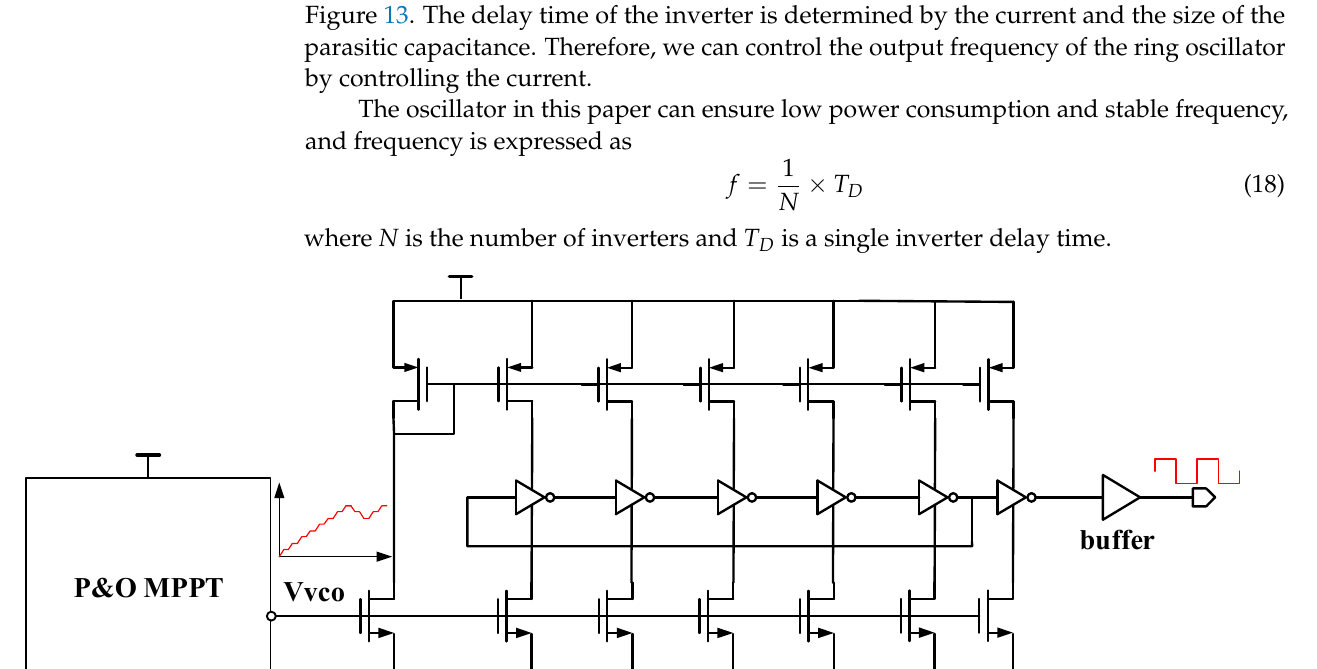
Figure 13. The delay time of the inverter is determined by the current and the size of the parasitic capacitance. Therefore, we can control the output frequency of the ring oscillator by controlling the current.